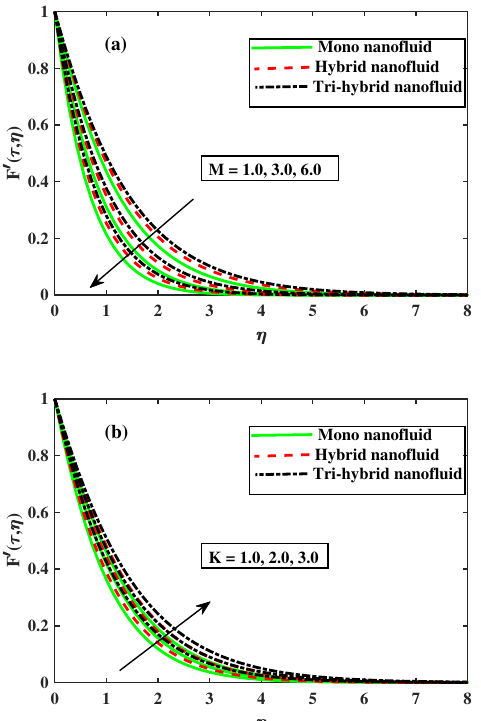
Figure 2. ( a ) Fluctuation of M on F (cid:48) ( τ , η ) ; ( b ) Fluctuation of K on F (cid:48) ( τ , η ) .